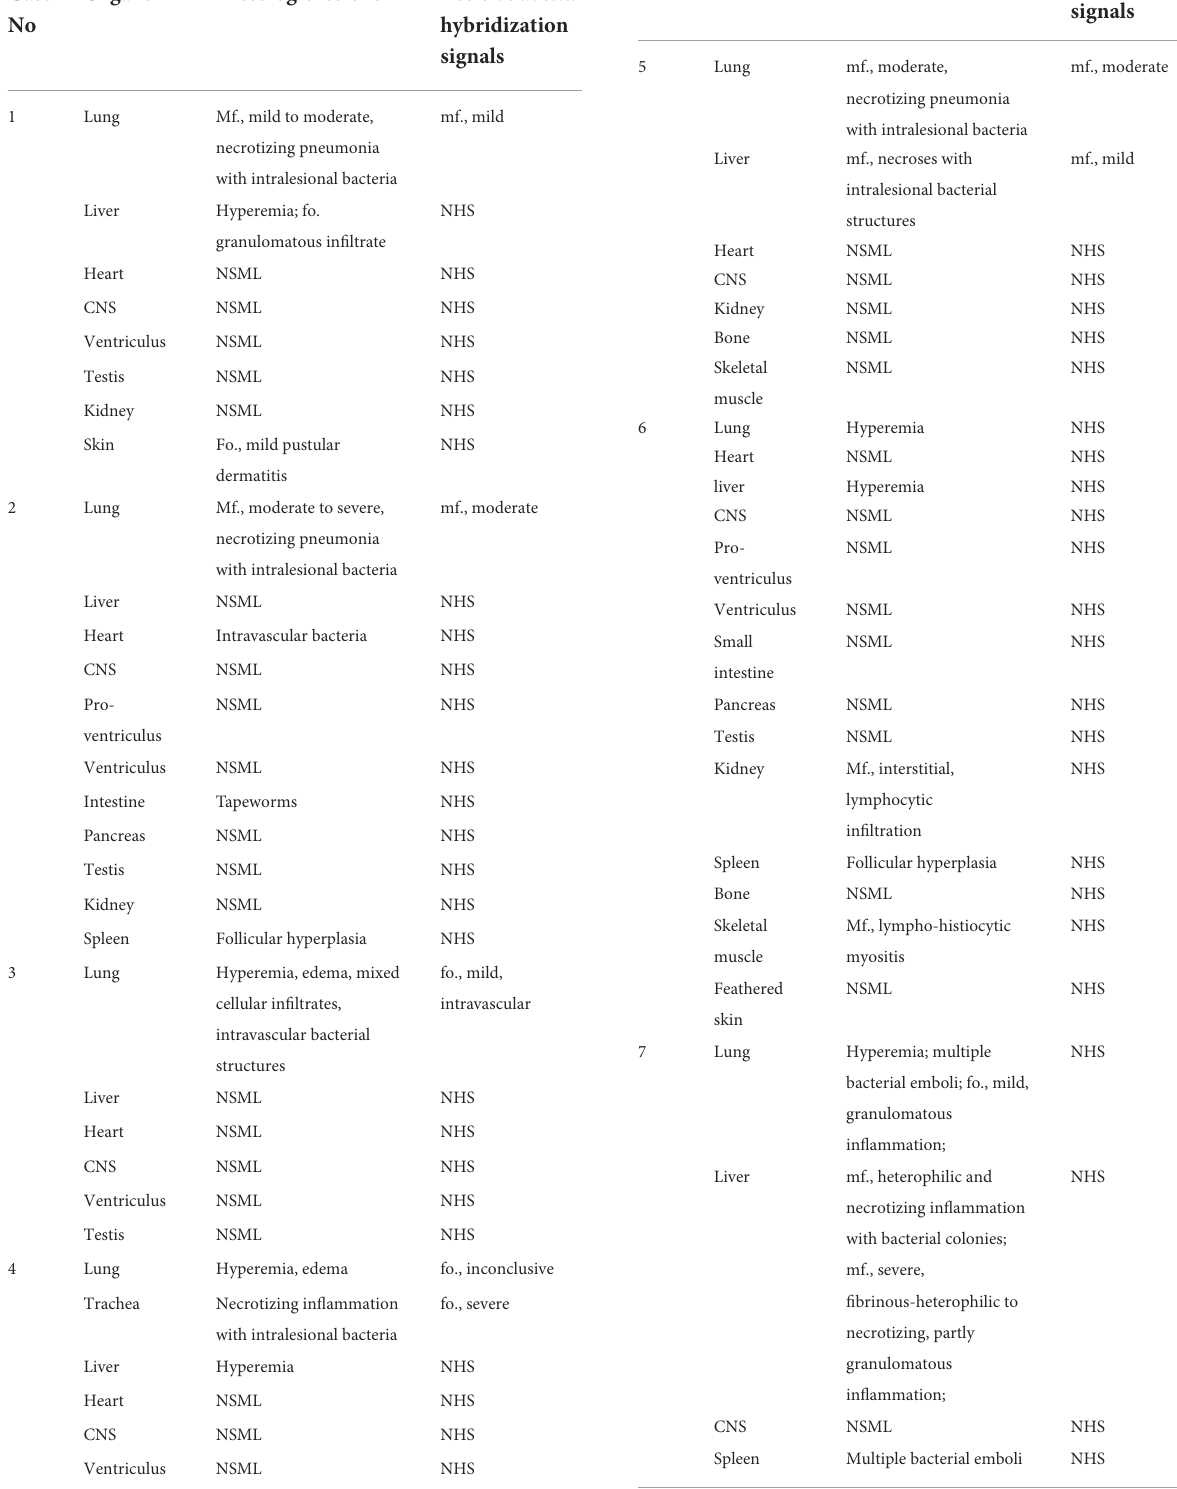
TABLE 2 Overview of the investigated animals summarizing the corresponding results of the histological and in situ hybridization analyses carried out on the cases